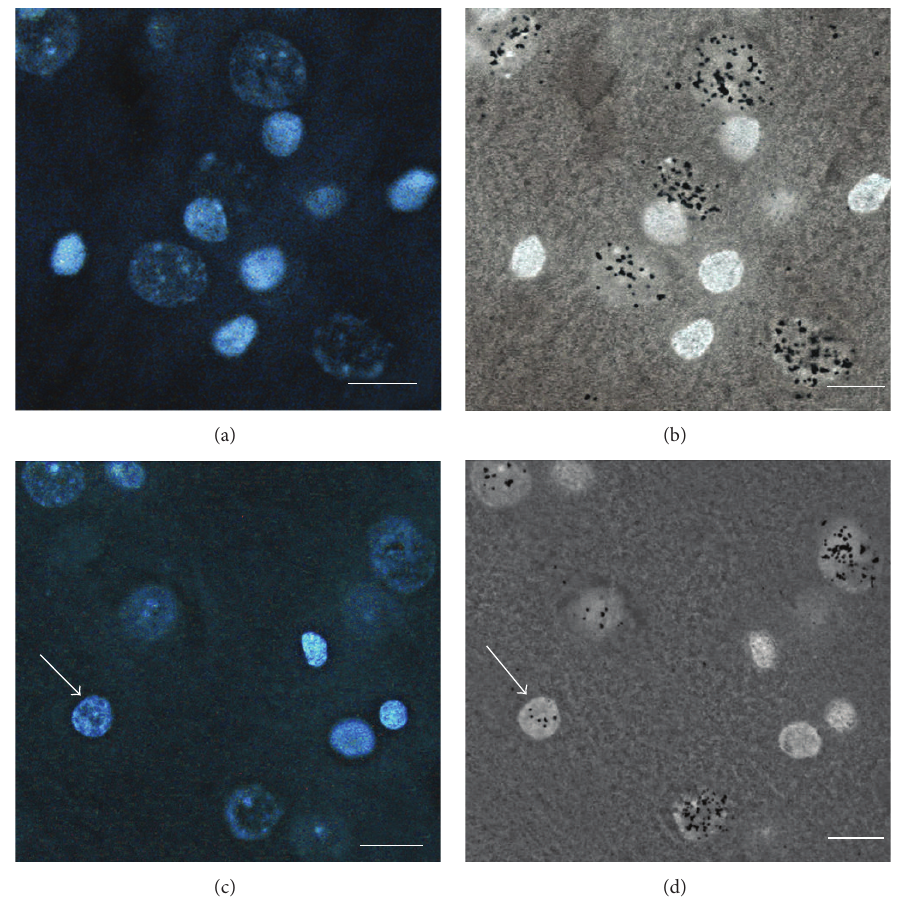
Figure 12: Autoradiography analysis of the RNA synthesis rate in a reprogramming oligodendrocytic nucleus. (a) Here, 5 neuronal nuclei and 6 oligodendrocytic nuclei can be observed in the field of view. (b) The same section area in transmitted light. All 5 neuronal nuclei are intensely marked by silver grains, while none of the 6 oligodendrocytic nuclei contain this label. (c) Another region of the preparation. In the field of view, 4 oligodendrocytic nuclei can be observed. A proneuronal change in the structure, with dark areas of euchromatin, is observed in the nucleus (arrow) that is the largest and is colored irregularly. (d) The same section area in transmitted light. The proneuronal structural change has a functional manifestation: the appearance of the label over the oligodendrocytic nucleus (marked by an arrow) indicates an increase in the RNA synthesis rate. (a) and (c) are stained with DAPI. (b) and (d) show manifestation of the autoradiographic label (silver grains). The scale bar is 15 𝜇